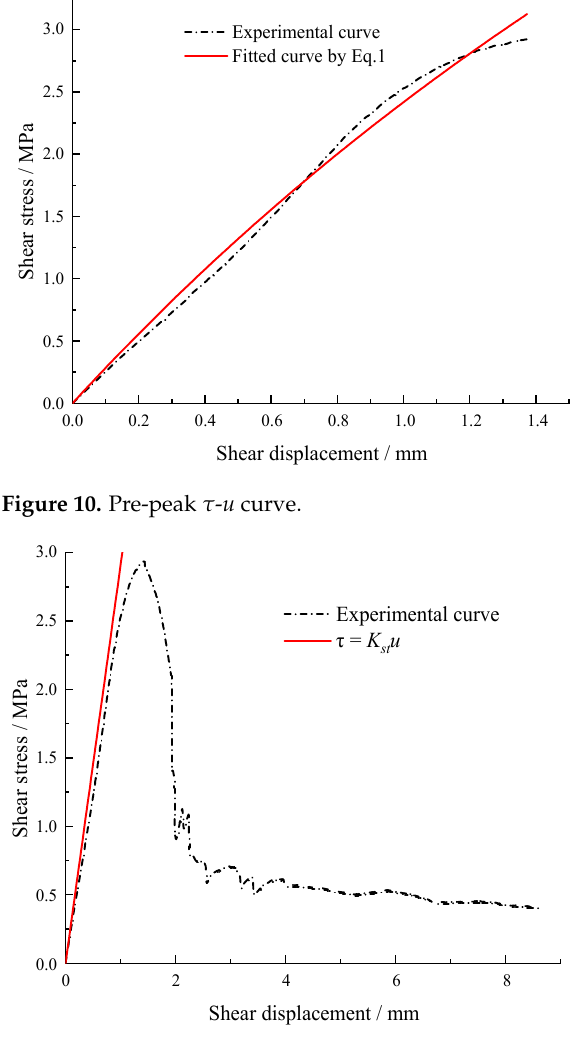
Figure 11. Determination by the shear stiffness method.